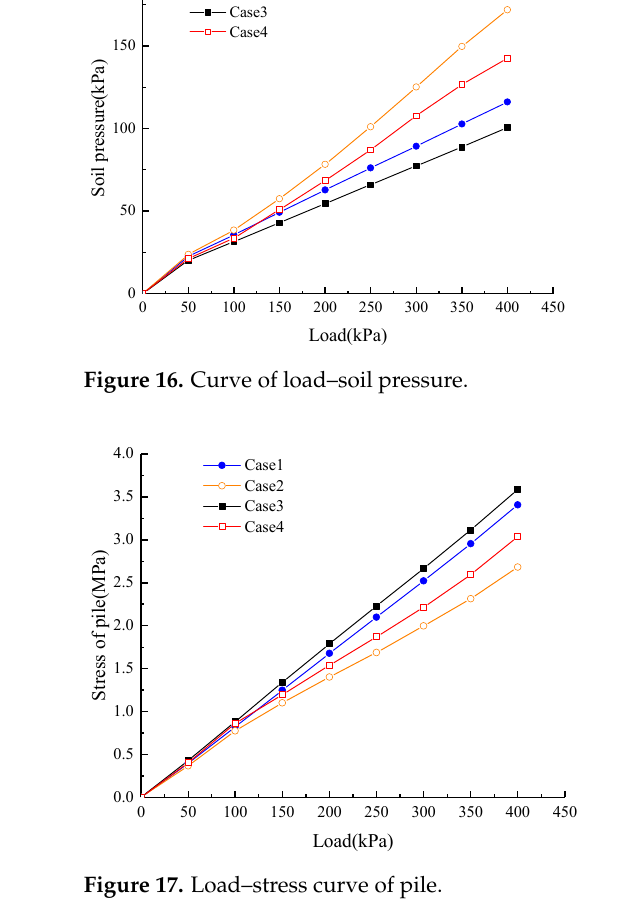
Figure 15. Settlement of a composite foundation(m): ( a ) Case 3; ( b ) Case 4.